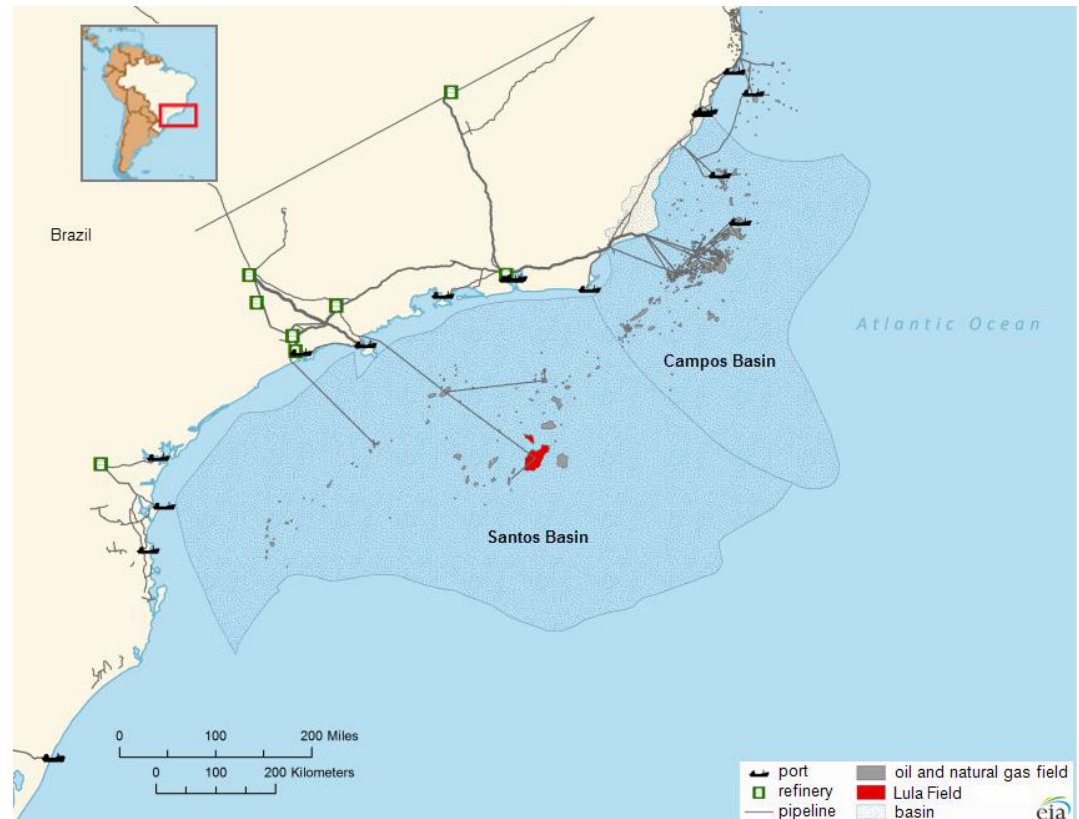
Figure 3. Location of the Campos and Santos basins. Source: eia.gov (accessed on 3 April 2021).